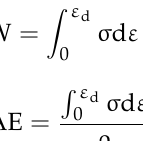
Figure 10. Comparison of the mechanical properties of different porous materials: ( a ) strength; ( b ) elastic modulus; ( c ) energy absorption; ( d ) energy absorption efficiency.